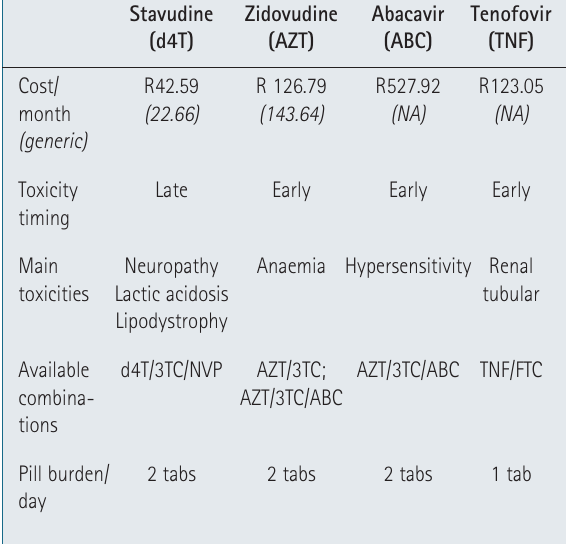
TABLE I. COMPARISON OF RAND COSTS PER MONTH (PUBLIC SECTOR TENDER PRICES MAY 2006), TOXICITIES, AVAILABLE CO-FORMULATIONS AND PILL BURDEN